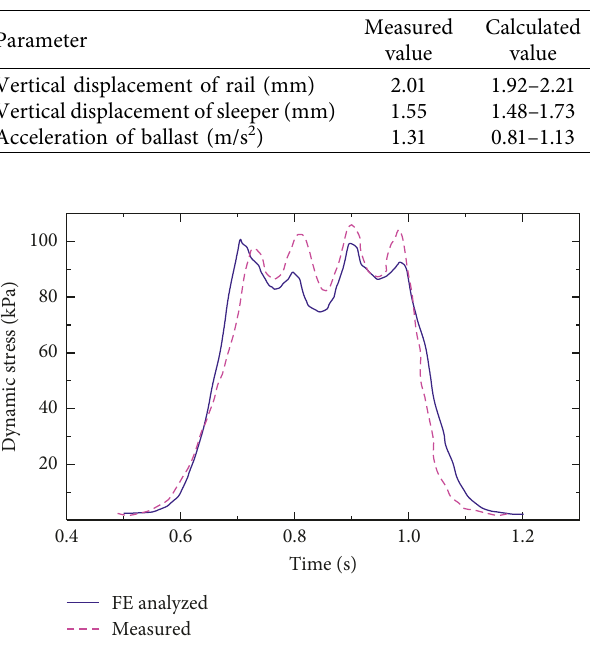
Figure 7: Rail model: (a) before modification; (b) after modification. Table 4: Measured and simulated vertical displacement of the rail and sleeper.